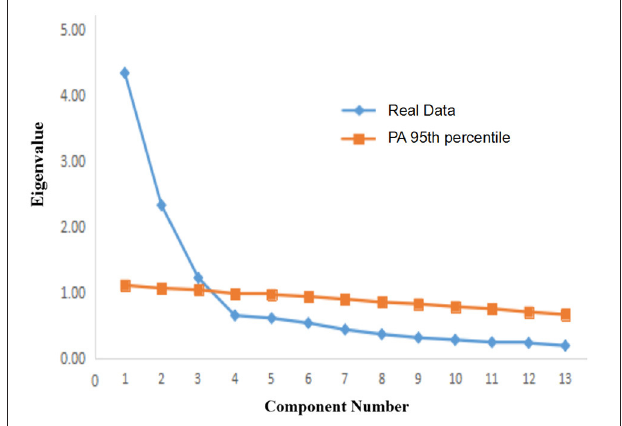
FIGURE 2 | Plot of the first 13 eigenvalues on PACQ for mother.